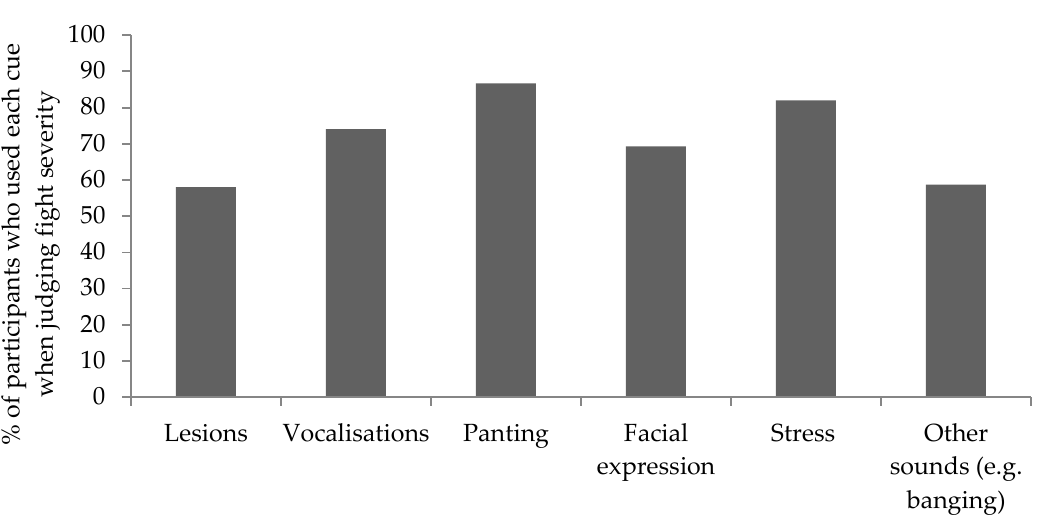
Figure 2. Percentage of participants who used each cue when judging fight severity.